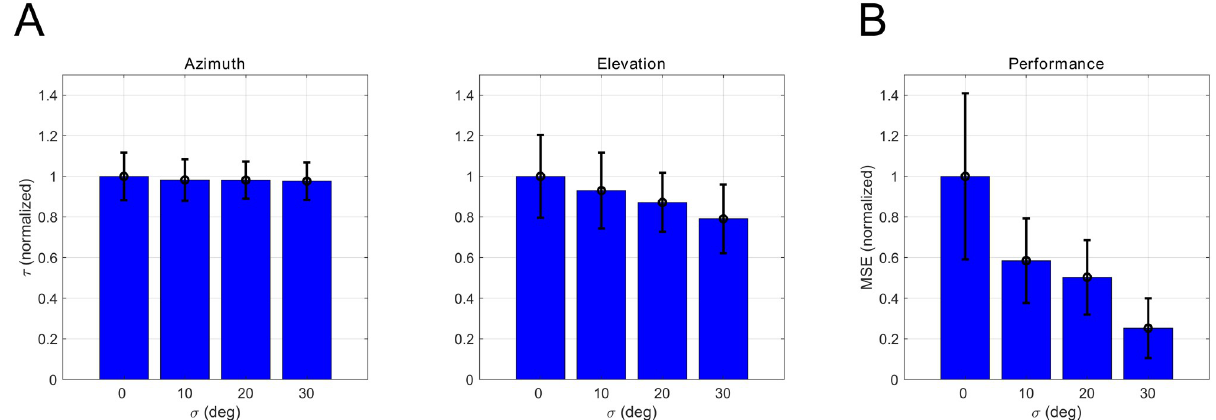
Fig 4. Summary statistics of generated trajectories. (A) The normalized time constant of the trajectories in azimuth, elevation direction. (B) The normalized mean squared error of the steady state head direction.